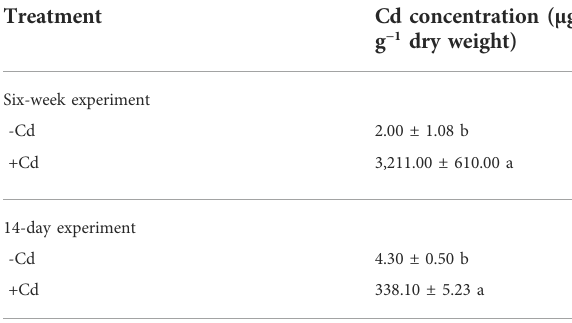
TABLE 1 Cadmium concentration in shoots of S. alfredii seedlings treated with 0 (-Cd) or 100 μ mol · dm ⁻ ³ (+Cd) CdCl 2 at the end of long- (six weeks) and short- (14 days) term aphid infestation experiments. Data represent means ± SD (n = 4). Different letters indicate signi fi cant differences between the control and Cd- treated plants ( t -test, p <